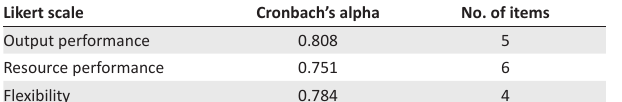
TABLE 1: Reliability statistics. Likert scale